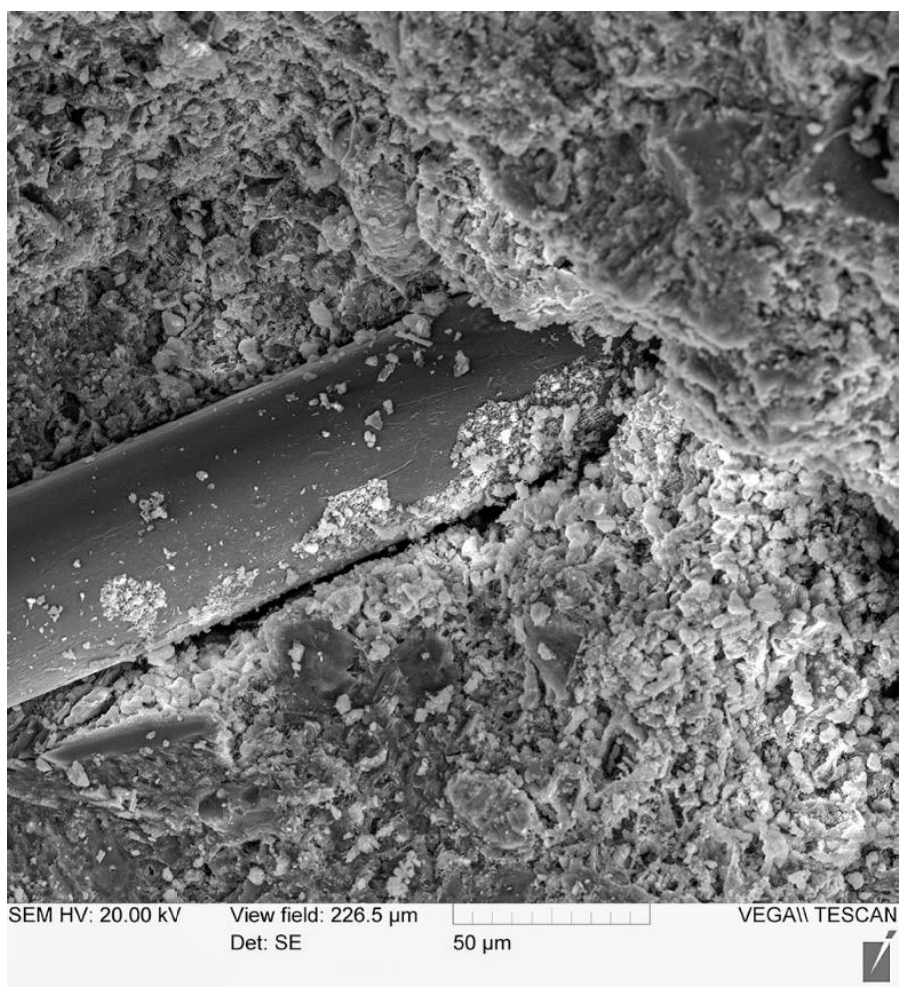
Figure 13. The contact zone and the nature of the interaction of the fiber with the cement matrix.